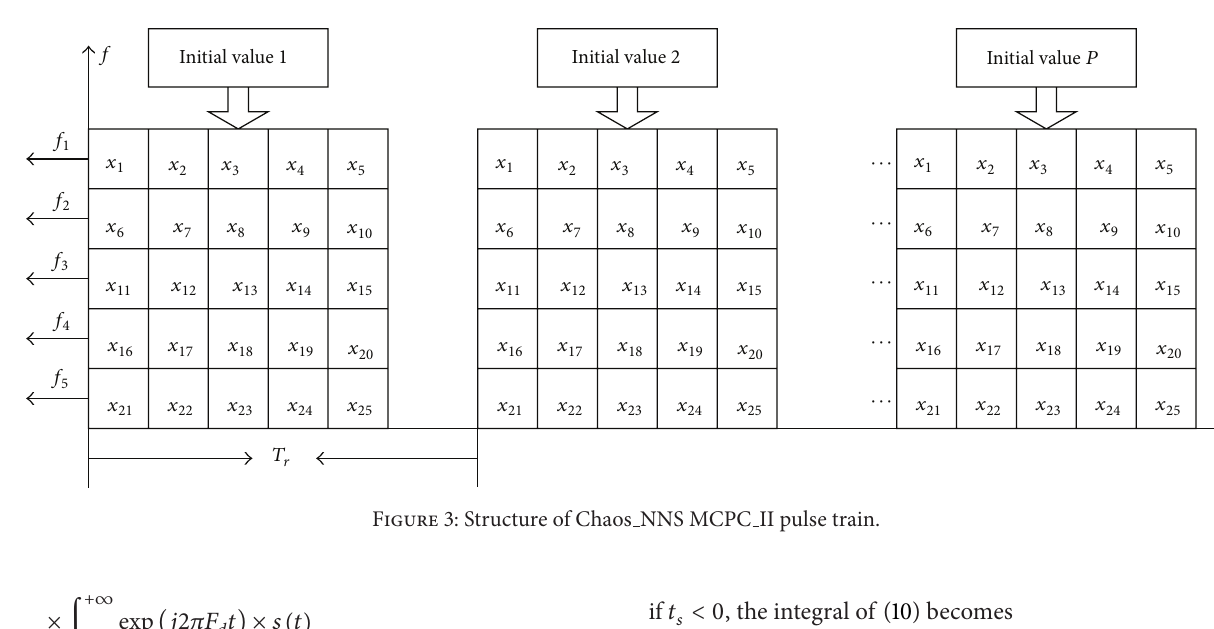
Figure 3: Structure of Chaos NNS MCPC II pulse